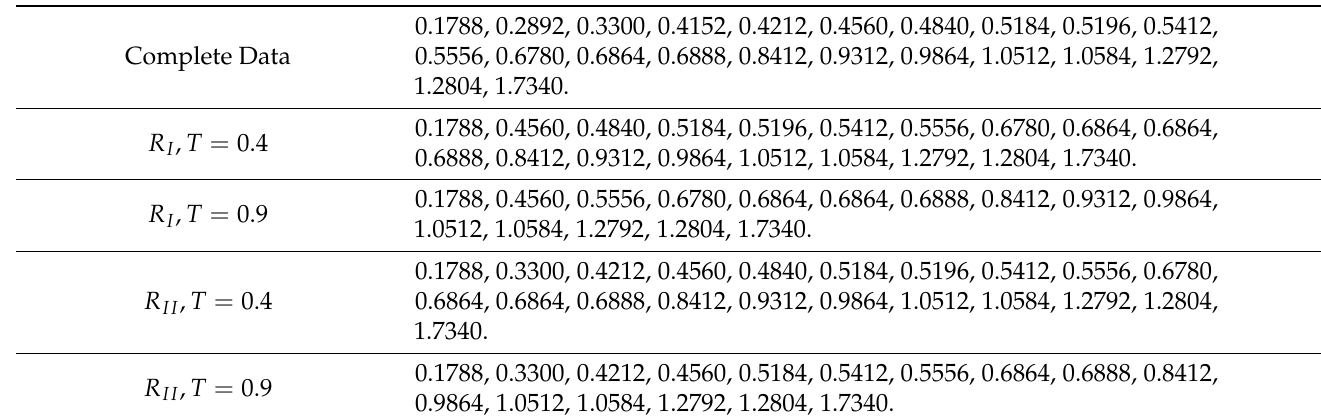
Table 5. The complete data and adaptive progressive type II censoring data under different schemes based on data set.